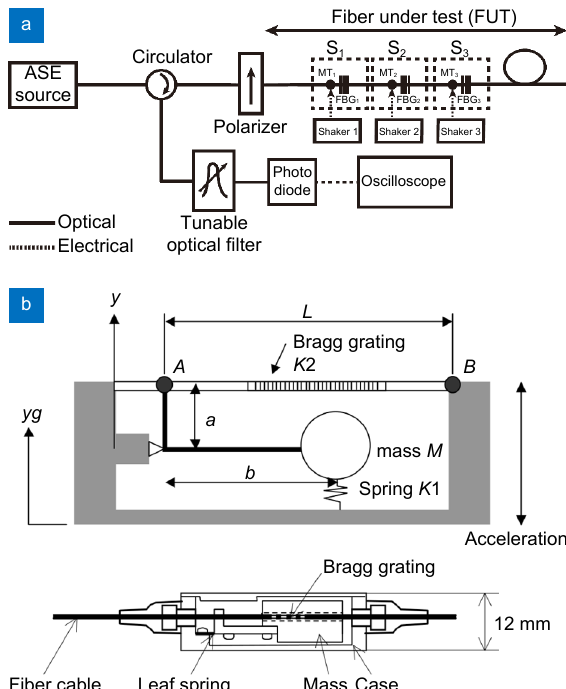
Fig. 13 | ( a ) Schematic of a multi-point FBG based accelerometer. ( b ) Simplified model and physical picture of an FBG based accelero- meter. Figure reproduced from: (a) ref. 48 , Optical Society of America; (b) ref. 50 ,